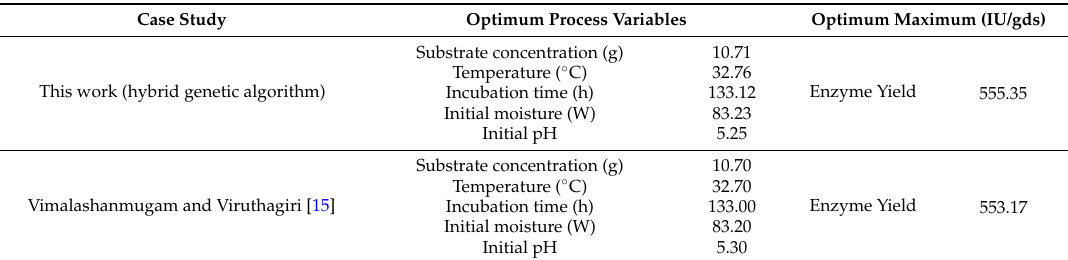
Table 9. Results for the case study on the xylanase